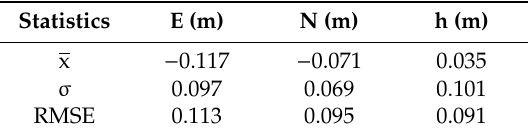
Table 4. Statistics: Average (x), standard deviation ( σ ), and root mean square error (RMSE) of the checkpoints in East (E), North (N), and height (h)